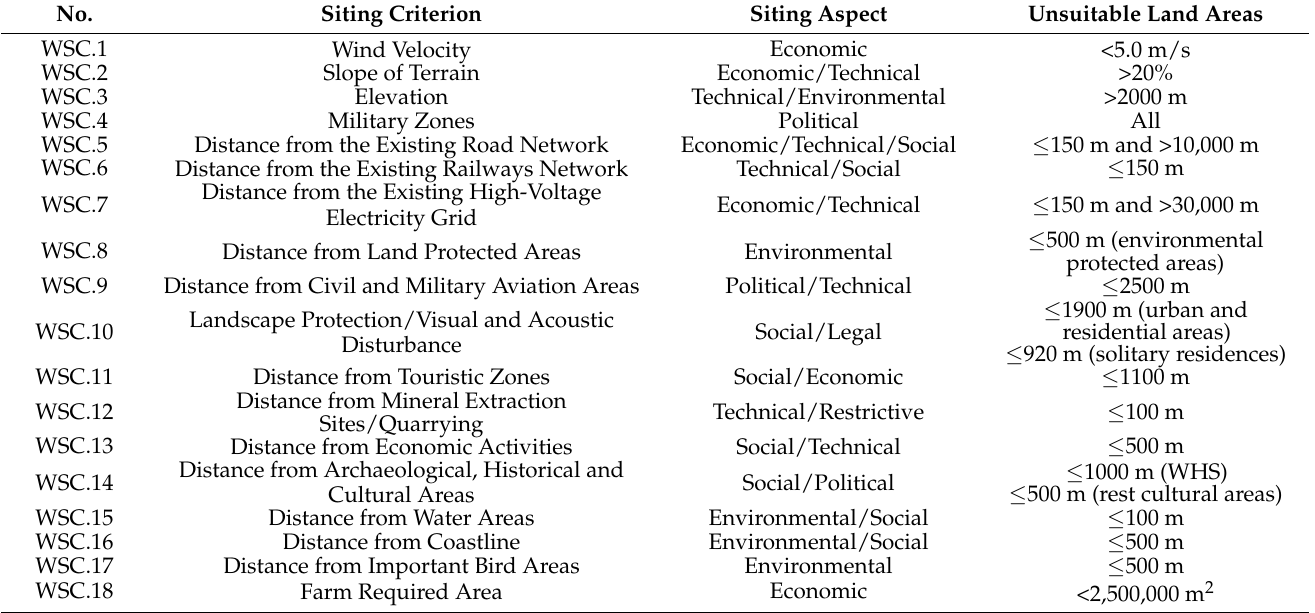
Table 2. Siting Criteria (SC) and their incompatibility zones for large-scale Wind Farms’ (WFs’) site-selection.